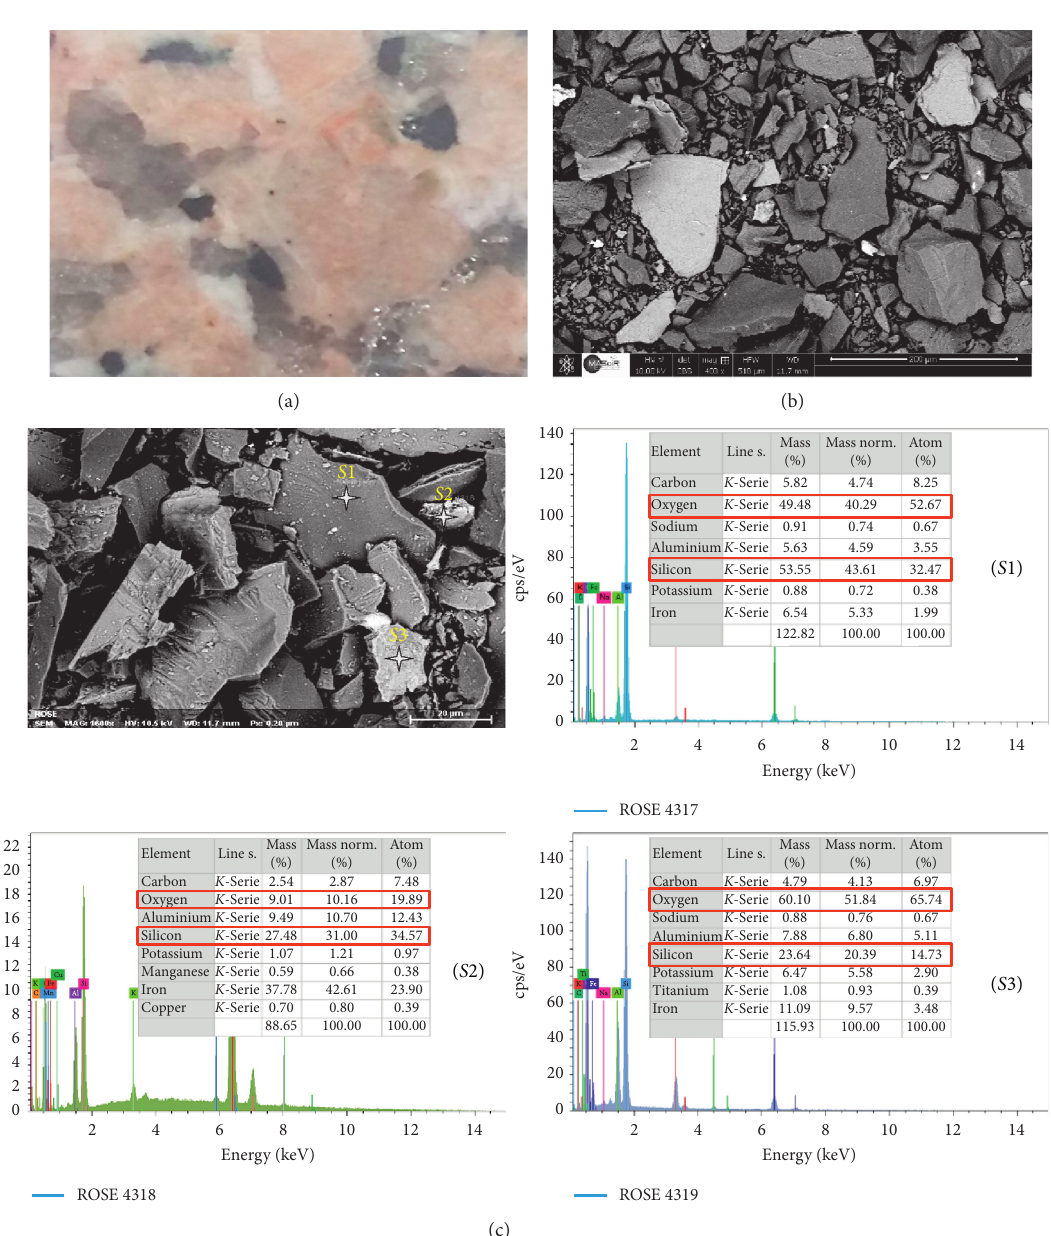
Figure 4: Optical image (a), SEM images (b) and (c), and corresponding local EDS analysis in different sides (S1, S2, and S3) of Rosa Porrino